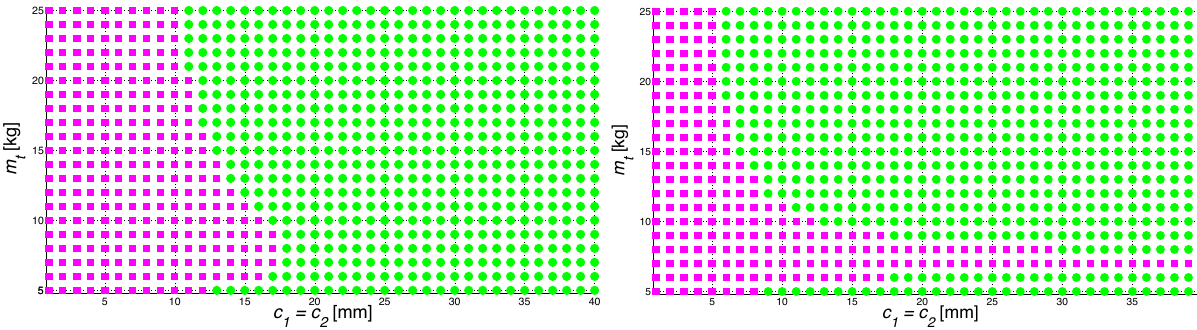
Fig. 5 Contour plot of the peak-to-peak vibration of the rotor frame dependent on the clearance c 1 = c 2 and the mass of the impact element m t for the excitation frequency (left) ω = 100 rad s − 1 and (right) ω = 115 rad s − 1 .